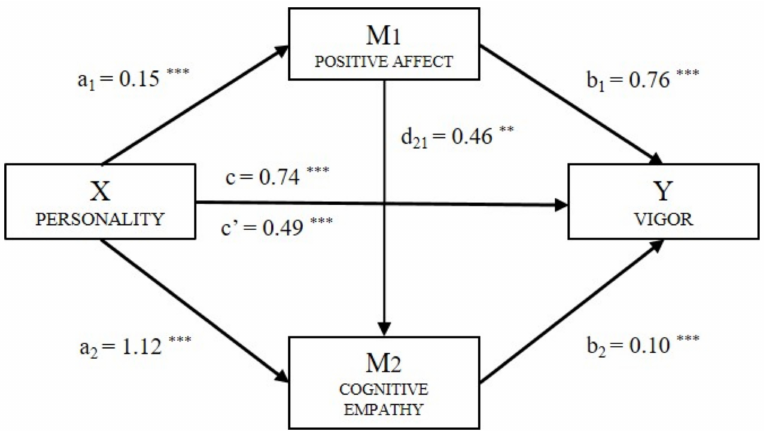
Figure 2. Multiple mediation model of positive affect and cognitive empathy on the relationship between personality and Vigor (Note. ** p < 0.01, *** p <